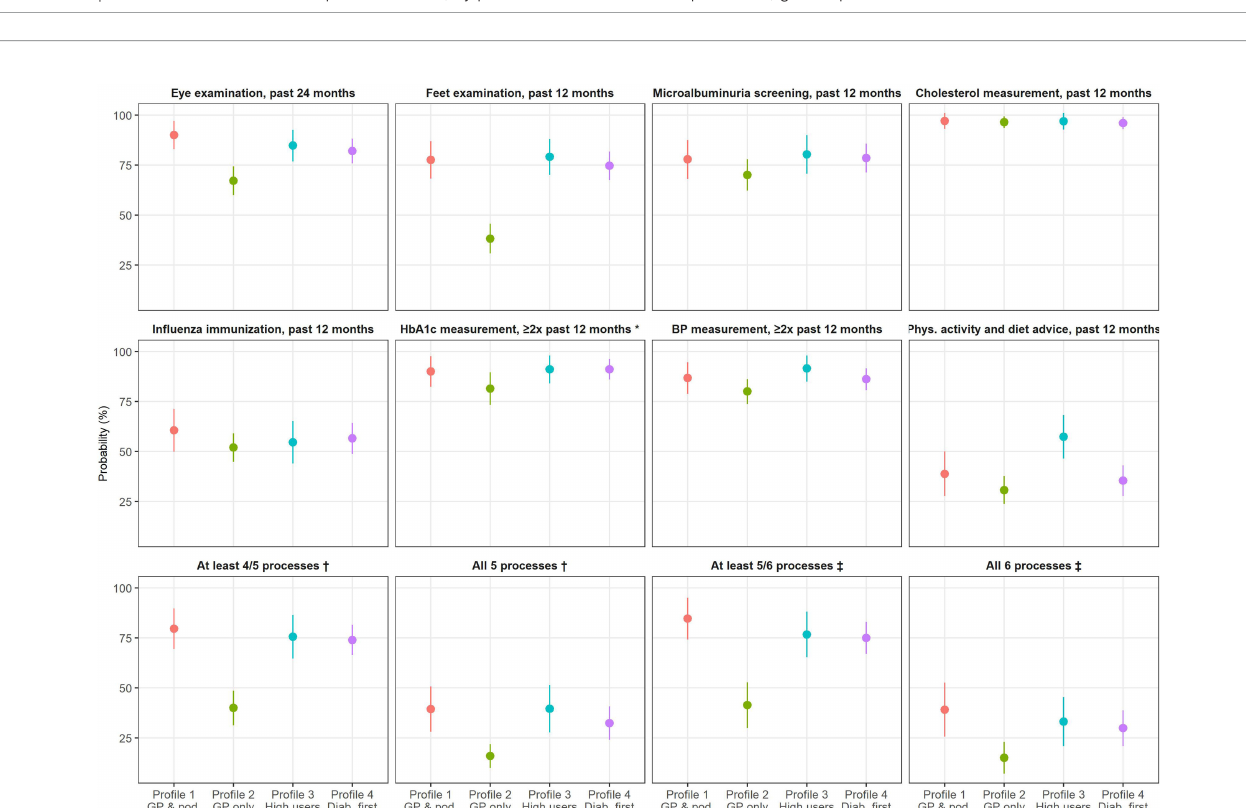
FIGURE 2 | Adjusted probabilities of receiving recommended processes of care, by healthcare use pro fi le. GP, general practitioner. HbA1c, glycated hemoglobin. BP, blood pressure. Probabilities estimated from logistic regression models (predictive margins). Adjustment: age, sex, living arrangement status, residential location, education level, mandatory health insurance model, subsidies for mandatory health insurance, and diabetes-related complications. *Only participants who have already heard about HbA1c. † Among the following: eye examination, foot examination, microalbuminuria screening, blood cholesterol measurement, and in fl uenza immunization. ‡ Among the following: eye examination, foot examination, microalbuminuria screening, blood cholesterol measurement, in fl uenza immunization, and HbA1c